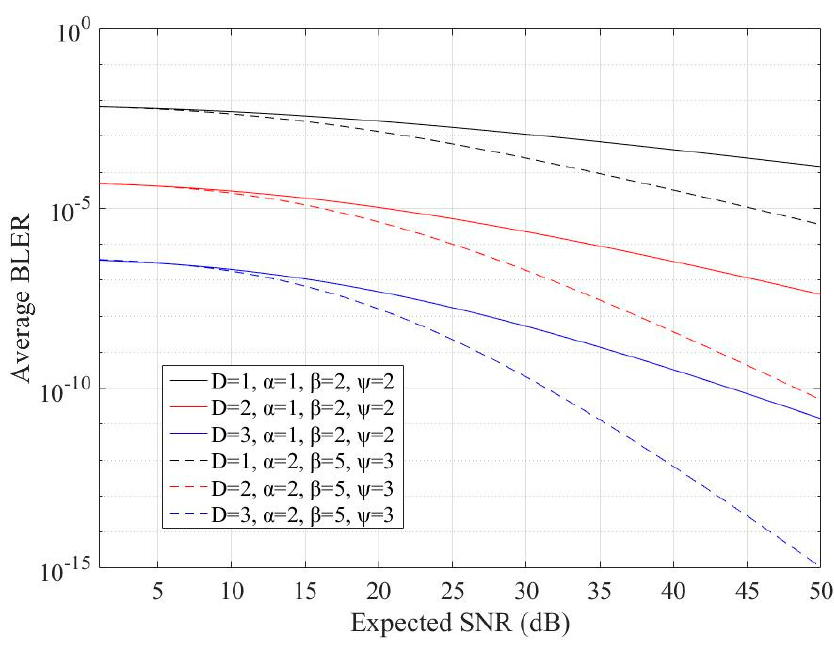
Figure 3. ABLER performance versus the expected SNR for M = 3, N = 5, and 8-PAM scheme.